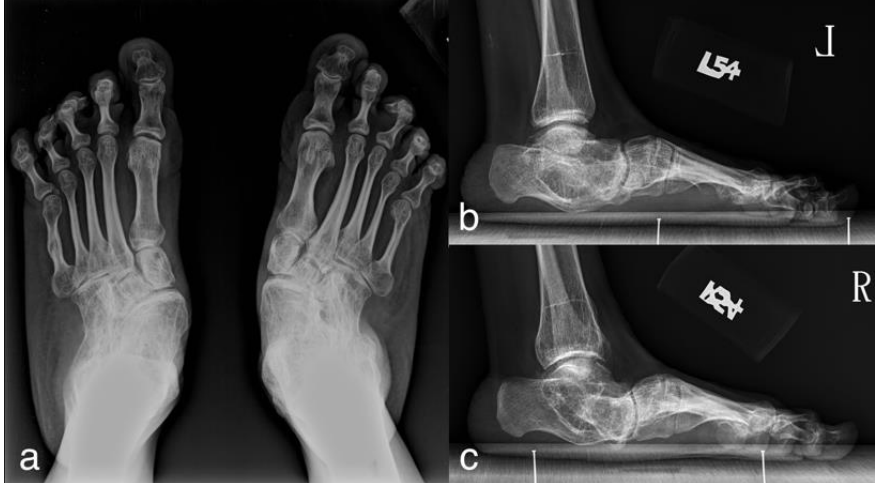
Figure 1. A 52-year-old woman with Sillence type I osteogenesis imperfecta (OI) and symptomatic flatfoot showing severe foot deformity. ( a ) AP radiograph; ( b , c ) lateral radiograph of left and right feet.